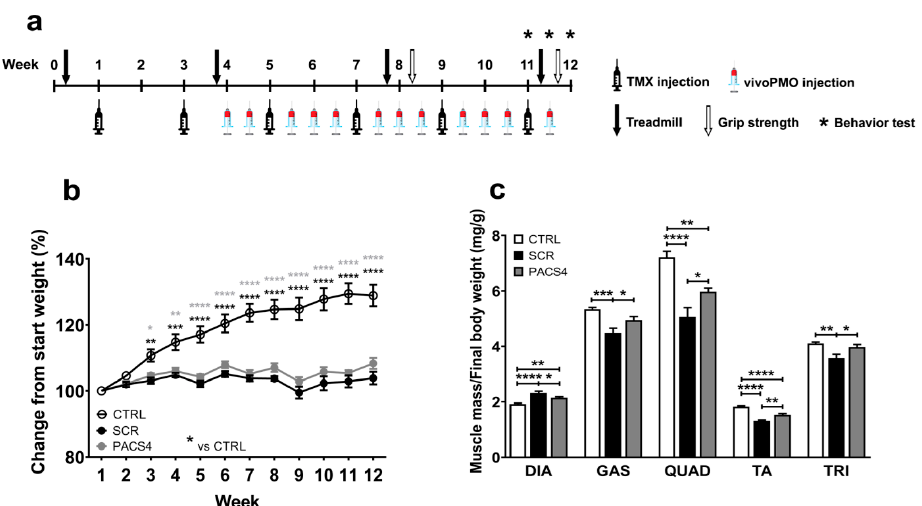
Figure 1. vivoPMO-PACS4 treatment improved body-wide muscle weight. ( a ) Diagram of the experi- ment, including timepoints of injections of tamoxifen (TMX) to induce DUX4 expression and vivoP- MOs, and functional tests. All mice received 6 × 1.5 mg/kg/injections of TMX via intraperitoneal (IP) delivery. ACTA1-MCM/FLExDUX4 mice were further IP injected with 12 × 10 mg/kg/injections of either vivoPMO-PACS4 (PACS4, n = 6) or vivoPMO-SCR (SCR, n = 6), considered as a